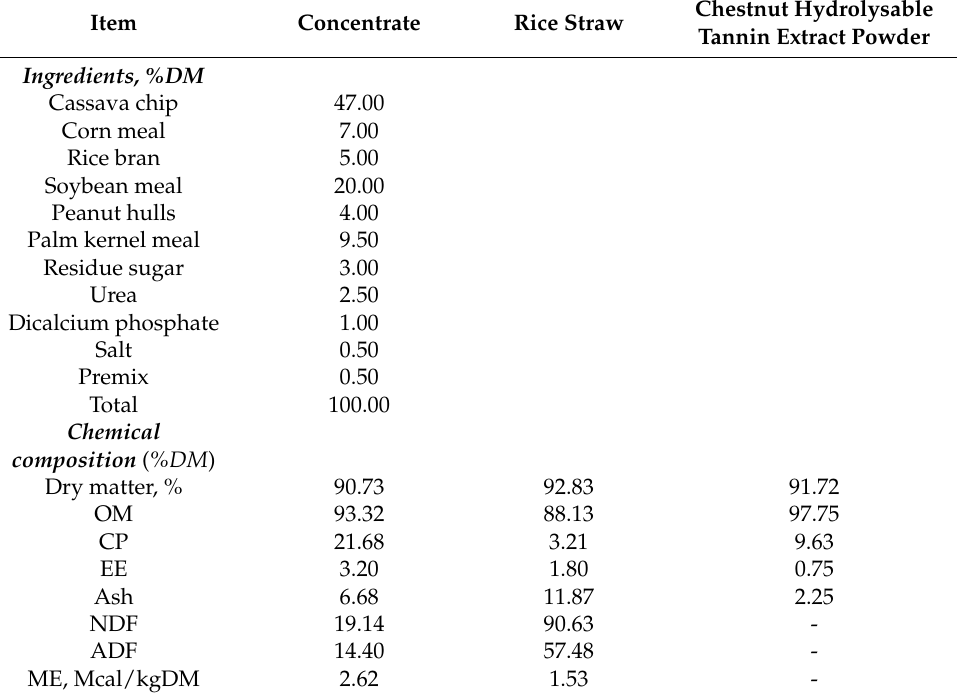
Table 1. Ingredients of the concentrate and chemical composition of concentrate, rice straw and chestnut hydrolysable tannin extract